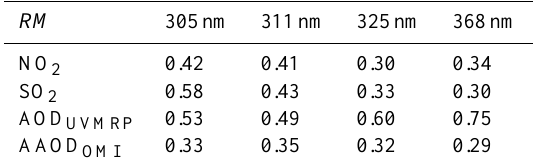
Table 3. The correlation coefficients across all 27 sites of the clear- sky relative mean biases ( RM ) at 305, 311, 325, and 368nm with the major tropospheric trace gases (NO 2 and SO 2 ) and aerosol optical depth from UVMRP and aerosol absorbing optical depth from